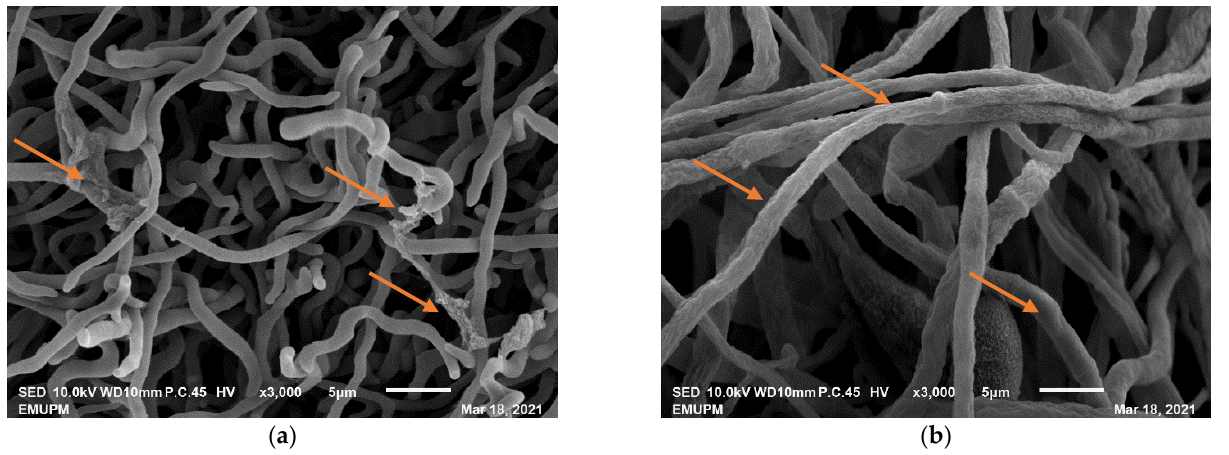
Figure 2. Micrographs of the scanning electron microscope (SEM) at a magnification of X3000. ( a ) Mycelia of Pyricularia oryzae fungus treated with chitosan nanoparticle, the mycelial growth was smaller with breakage at some points when compared to the control. ( b ) For the control, the mycelia of Pyricularia oryzae grown bigger, thicken, and without any breakage.